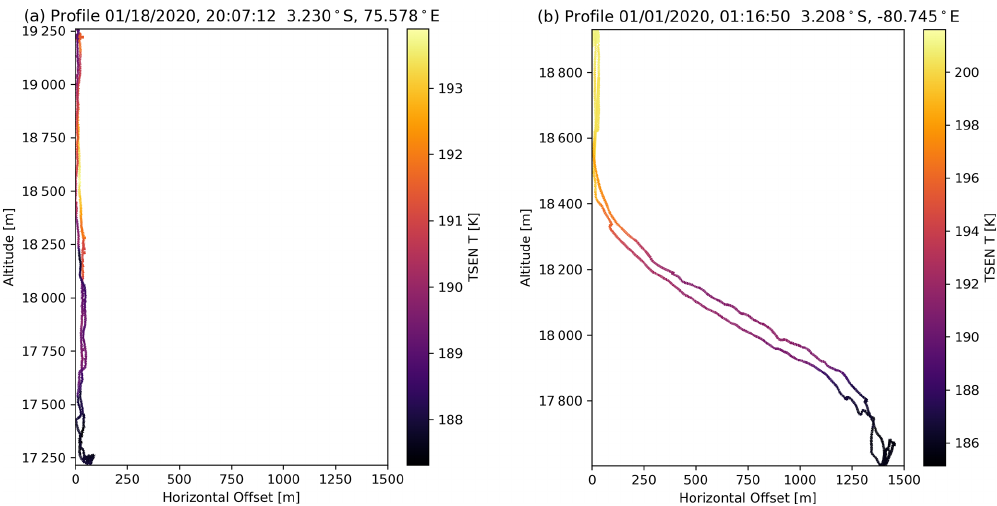
Figure 5. Horizontal offset of the profiling unit relative to the Zephyr gondola as a function of GPS altitude, color-coded by ambient temperature. (a) A low wind shear example demonstrating < 100m horizontal displacement and a nearly isothermal profile. (b) High wind shear example with 1400m horizontal displacement and 14K temperature gradient. The difference in motor torque between these profiles is